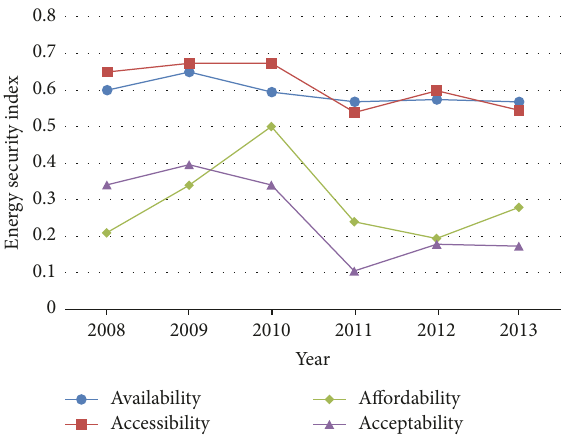
Figure 4: Each dimension of 4As from 2008 to 2013.